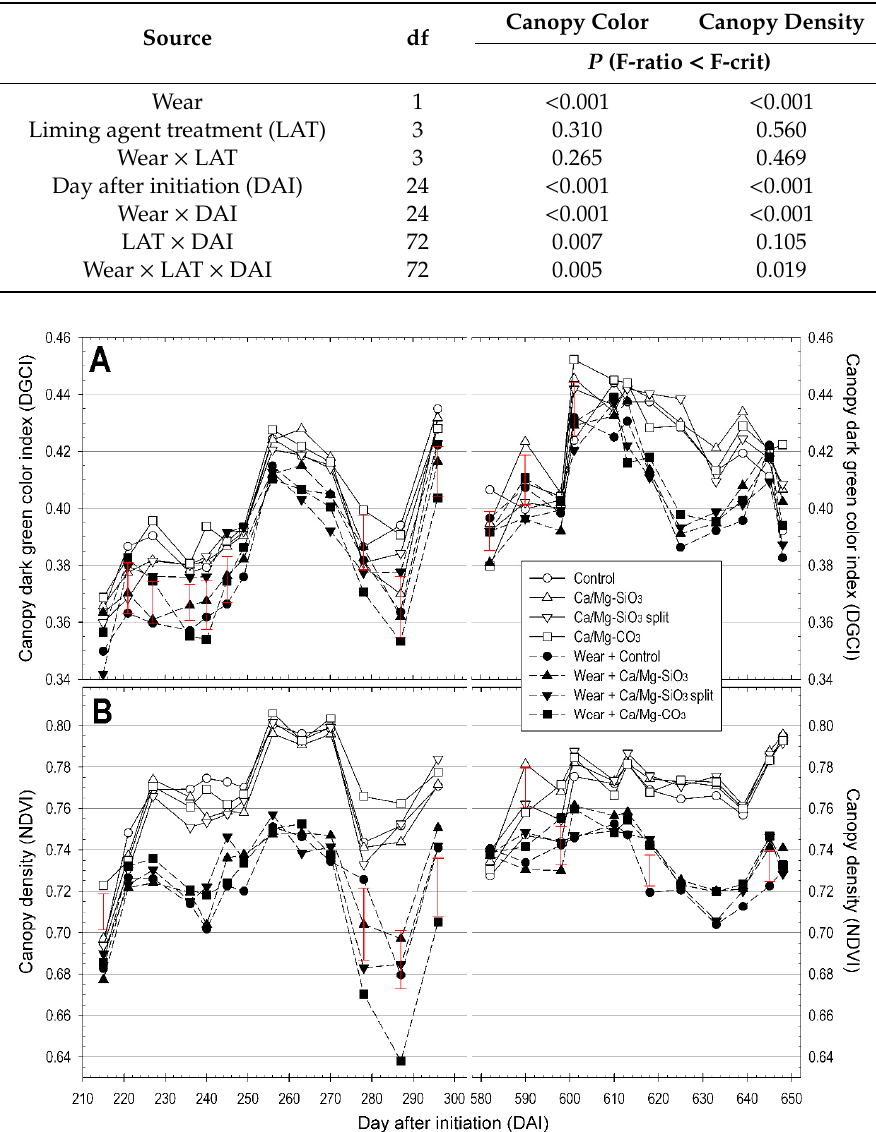
Figure 5. Creeping bentgrass ( A ) canopy dark green color index or ( B ) canopy density as influenced by the interaction of main-plot wear treatment, 2440 kg (ha year) –1 liming agent treatment, and respective day after initiation (DAI). For DAI specified, error bars depict least significant difference (alpha = 0.05) between treatment combination means.